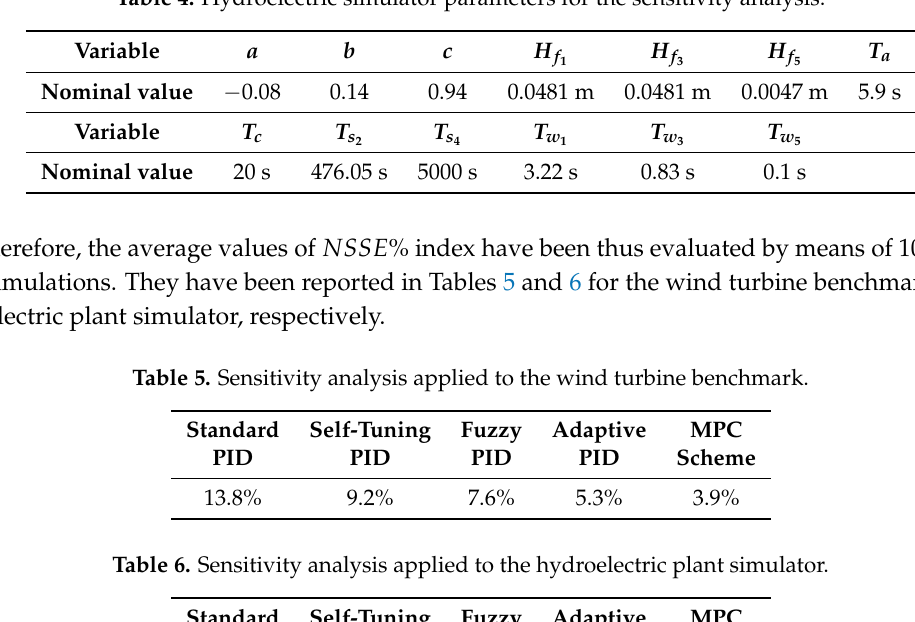
Table 4. Hydroelectric simulator parameters for the sensitivity analysis.